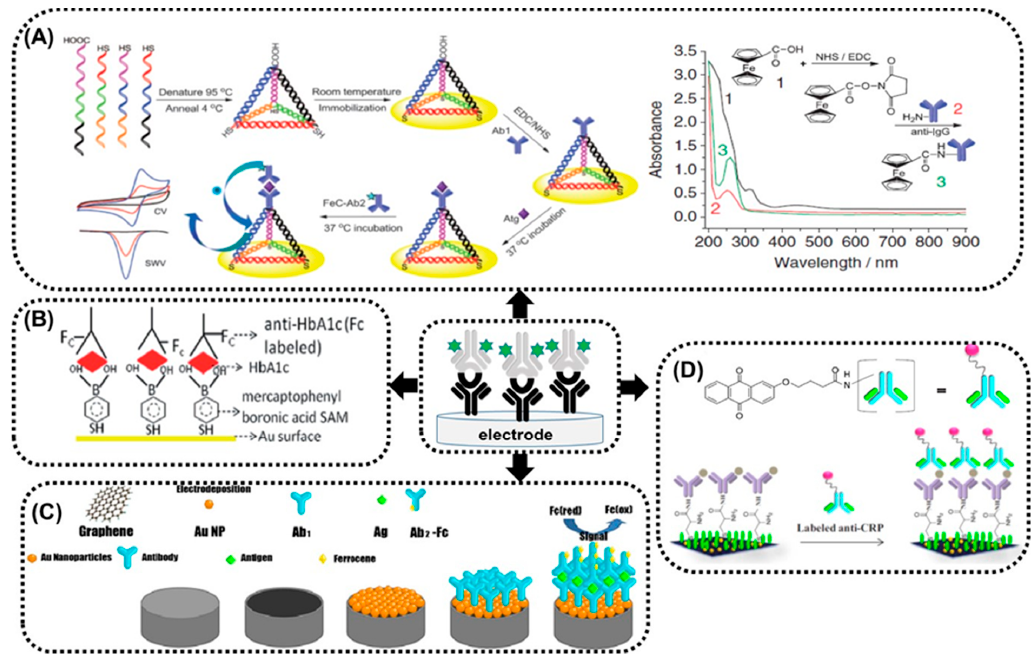
Figure 3. Selected examples of sandwich immunosensors based on electroactive label conjugates. ( A ) Schematic illustration of Au electrode modification using the DNA nano-pyramids (DPs) and ferrocene-labelled anti-IgG and Uv-vis spectra of ferrocenecarboxylic acid and anti-IgG, FeC-anti-IgG (reprinted with permission from Yuan et al. [43]). ( B ) Scheme of gold screen-printed sensor modification using mercaptophenyl boronic acid self-assembled monolayers and ferrocene-tagged anti-glycated haemoglobin antibodies (reprinted with permission from Chopra et al. [44]). ( C ) Scheme of the fabrication of the sandwich immunosensor based on graphene/gold nanoparticle composite and ferrocene-labelled secondary antibodies (reprinted with permission from Wang et al. [45]). ( D ) Schematic illustration of screen-printed graphene electrode modification using anthraquinone-labelled, C-reactive, protein-specific antibodies (reprinted with permission from Jampasa et al. [46].